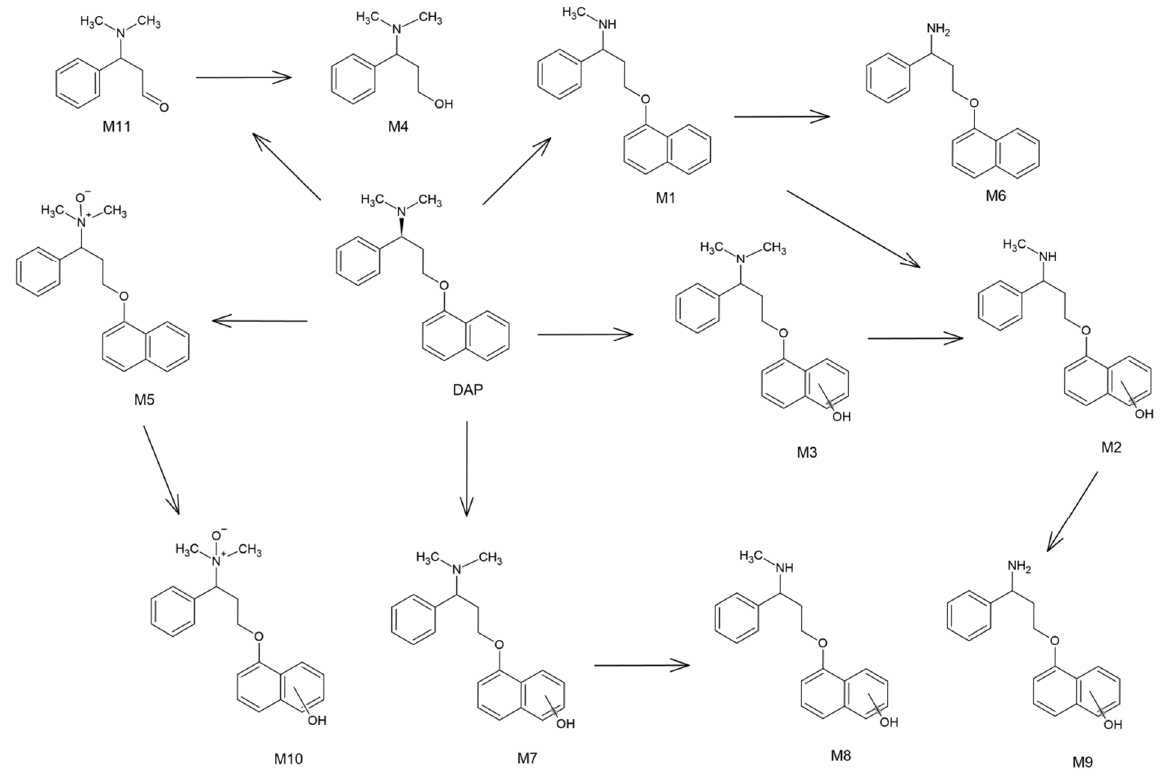
Figure 4. The proposed hepatic metabolic pathway of dapoxetine (location of the hydroxyl group involves the whole naphthalene ring).